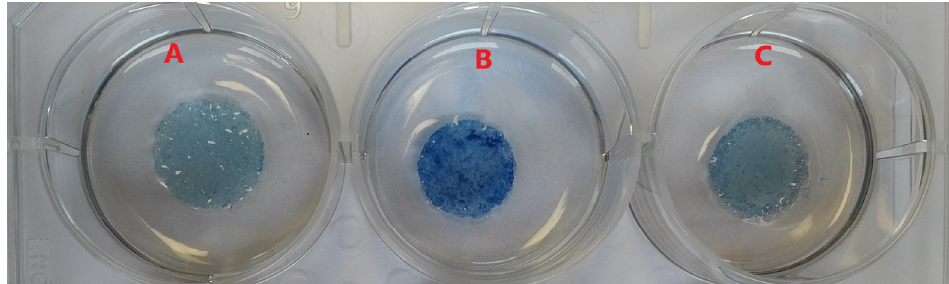
Figure 2. Coomassie blue staining: ( A ) PLA, ( B ) PLA/silk fibroin, and ( C ) PLA/gelatin